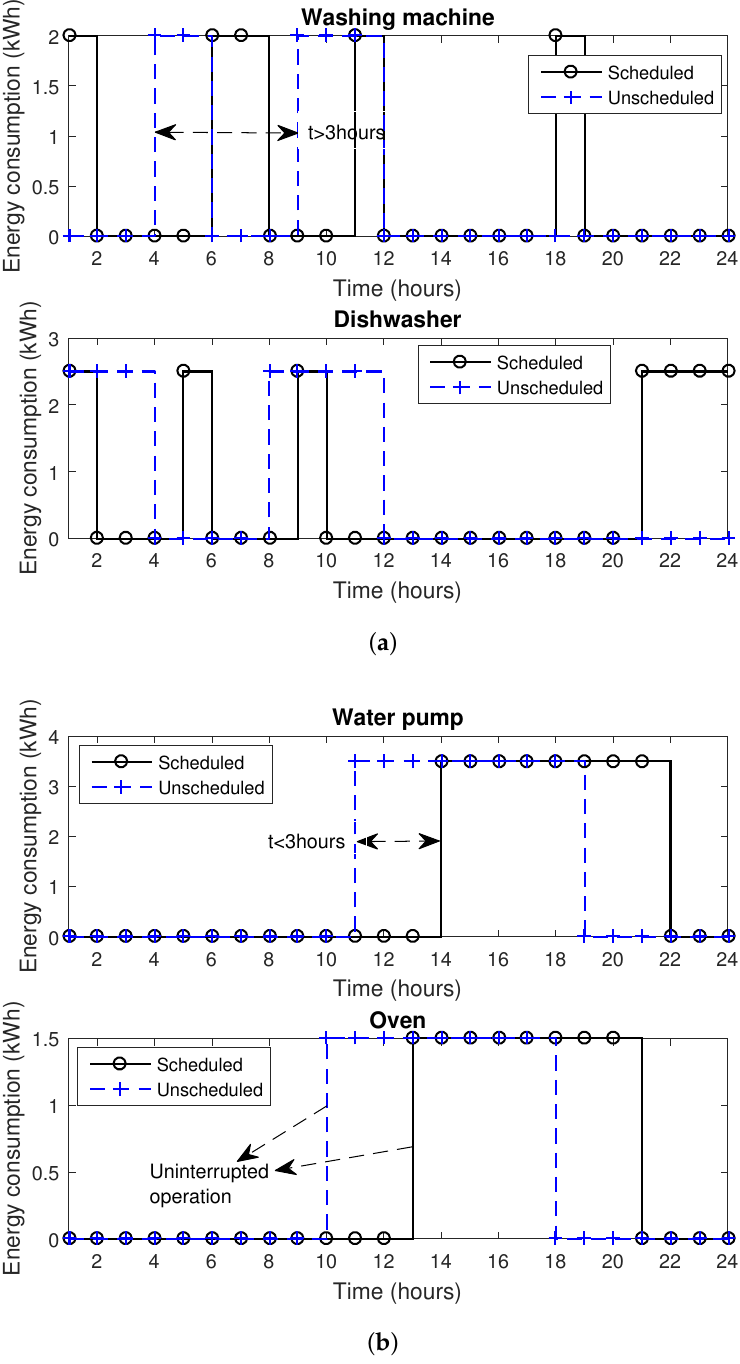
Figure 20. Appliance energy consumption and operating time slots in unscheduled and unscheduled cases: ( a ) energy consumption and optimal operating hours of el appliances; and ( b ) energy consumption and optimal operating hours of iel